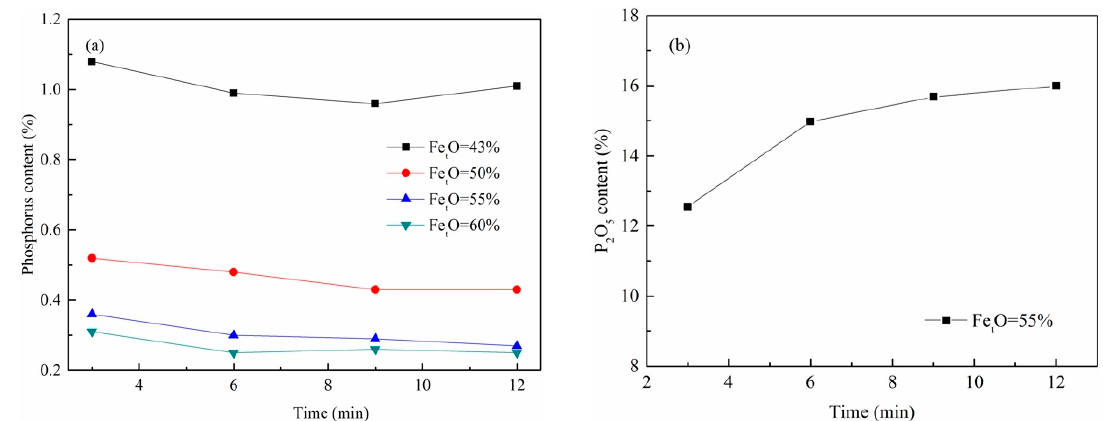
Figure 11. Effect of Fe t O content on the dephosphorization of the reduced iron: ( a ) phosphorus content of the molten iron; and ( b ) P 2 O 5 content of the dephosphorization slag.